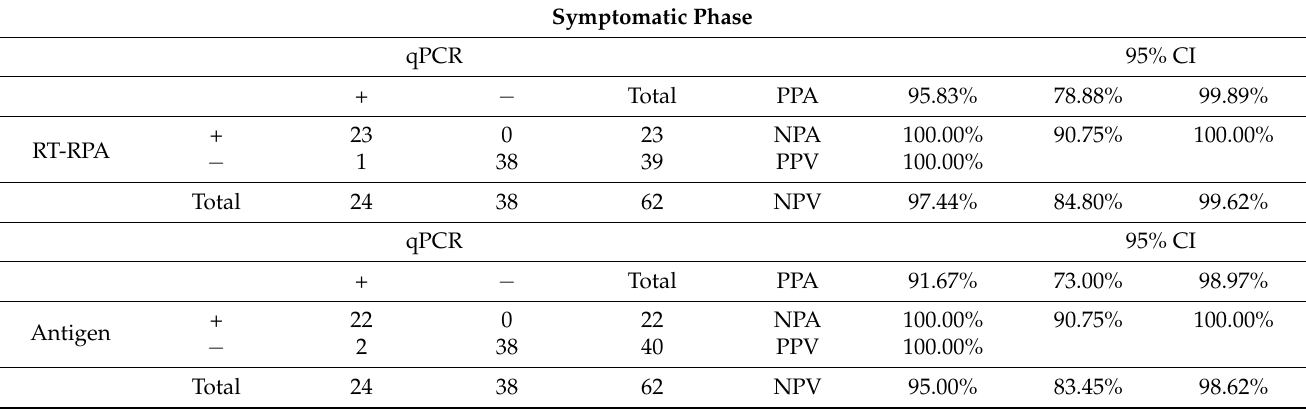
Table 2. Comparative performance of the RT-RPA assay and the antigen test against qPCR in symptomatic